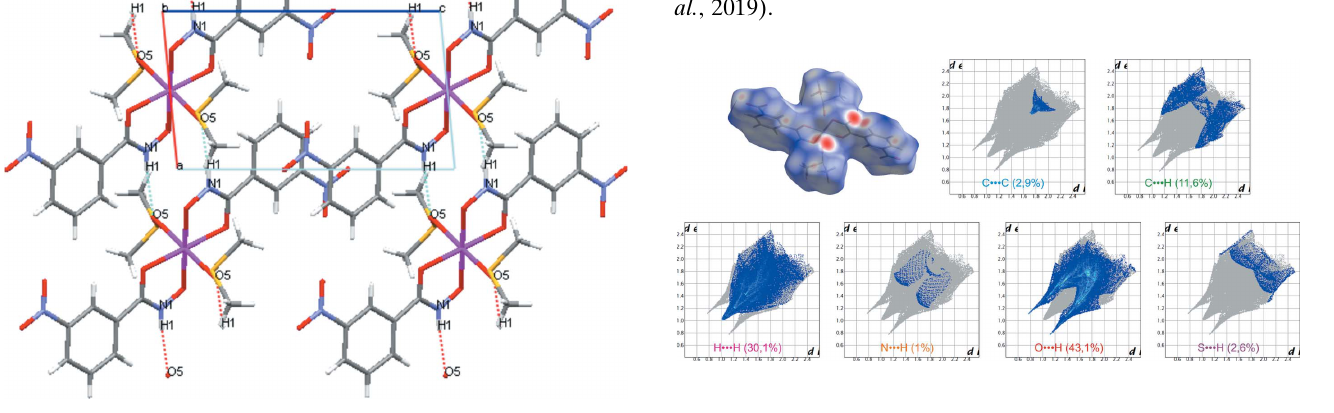
Figure 4 Results of Hirshfeld analysis for [Zn(NBZH) 2 (DMSO) 2